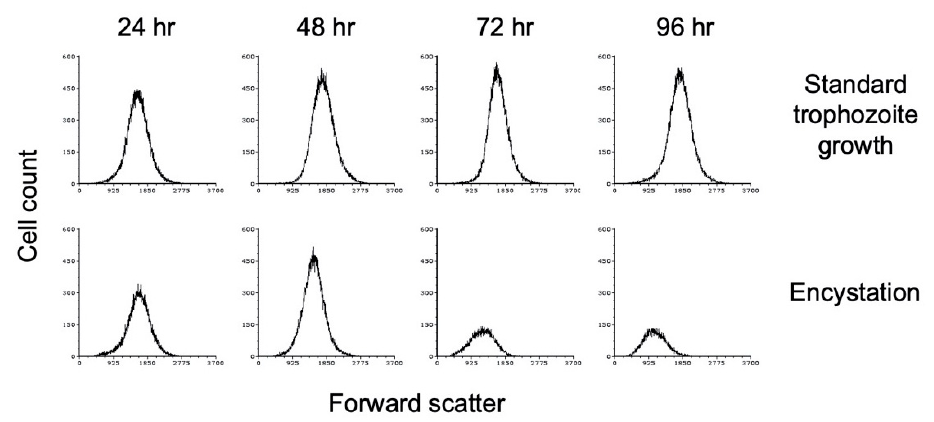
Figure 3. E. histolytica cysts are reduced in size versus trophozoites. Flow cytometry analysis was performed on WGA-488-stained E. histolytica cells during standard trophozoite growth (top) and encystation (bottom). Analysis was performed at 24 h intervals from 24 to 96 h and again at 168 h. Histograms display cell count versus forward scatter and are uniform for direct comparison of the position and size of the peaks. Three biological replicates were performed, and the results shown are representative.